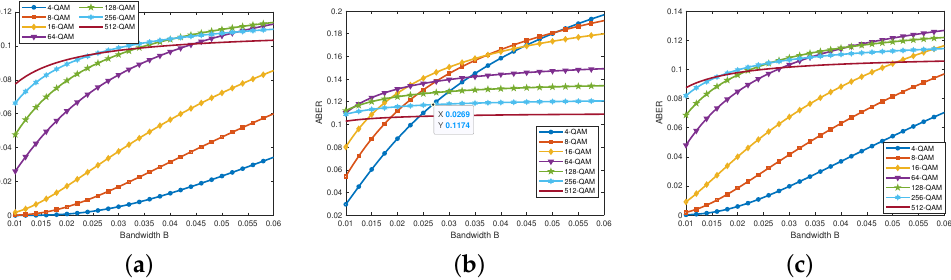
Figure 6. The bandwidth-limited ABER of POV carrier link with M-QAM versus ( a ) the propa- gation distance ( b ) turbulence strength. ( a ) z = 75 m, C 2 εχ